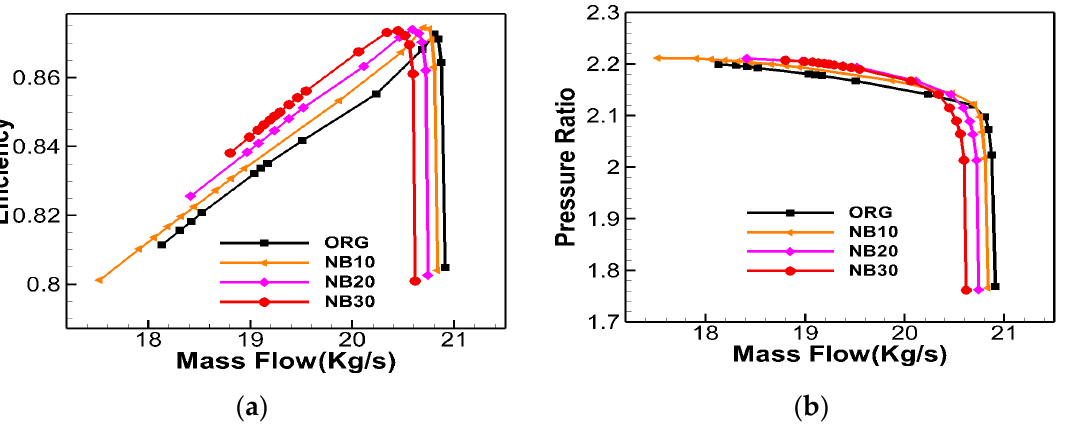
Figure 7. Comparison of isentropic efficiency and total pressure ratio of NB10, NB20, and NB30. ( a ) the isentropic efficiency. ( b ) the total pressure ratio. Table 3. Comparison of design point performance and stall margin of NB10, NB20, and NB30. Parameters Mass Flow (kg/s) Pressure